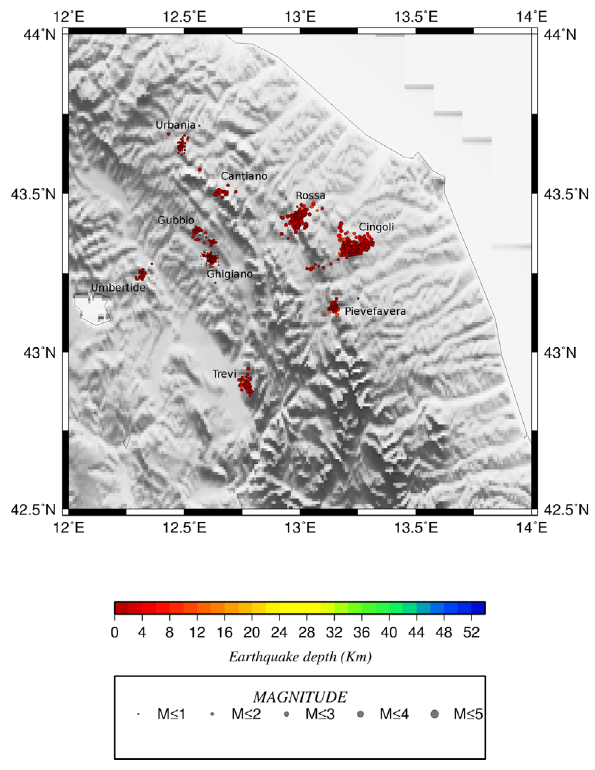
Figure 10. Seismicity for the period 1996-2012, as derived from the same catalogue of Figure 2 with the subtraction of the events classi- fied as “non-tectonic source”. Note the different mean depth distri- bution, in particular in the area between 43.3 and 43.5N, and between 13.0 and 13.5E.